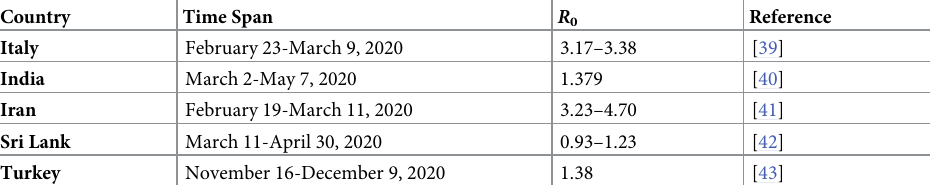
Table 4. Estimated R 0 for COVID-19 in different countries.